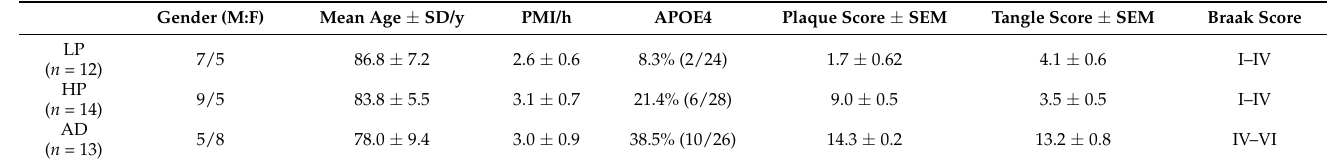
Table 2. Demographic information of cases used for immunoblot analysis. Series 2 (Abbreviations: LP, low-plaque non-demented; HP, high-plaque non-demented; AD, Alzheimer’s disease; M:F, male:female numbers; SD, standard deviation; PMI, postmortem interval; APOE4, percentage and numbers of cases with APOE4 genotype; SEM, standard error of